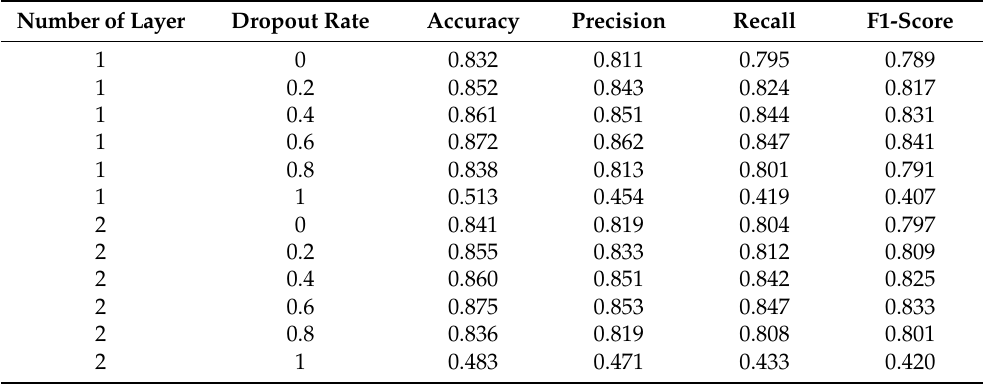
Table 2. Experiment results of BERT-BiLSTM